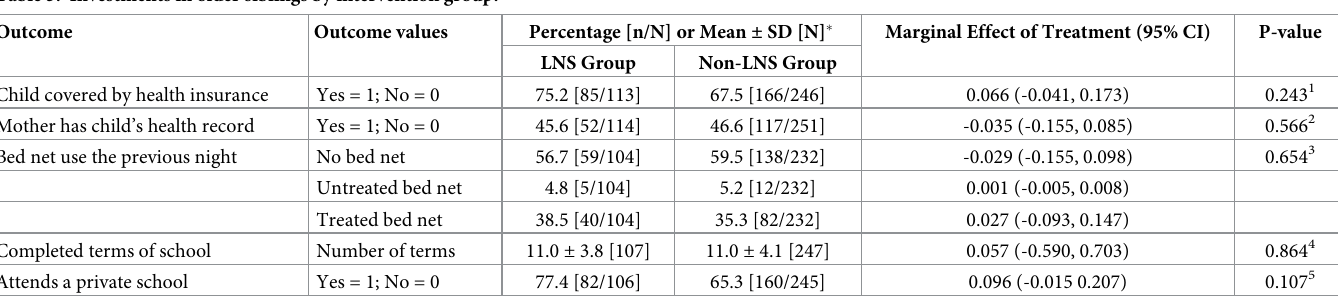
Table 5. Investments in older siblings by intervention